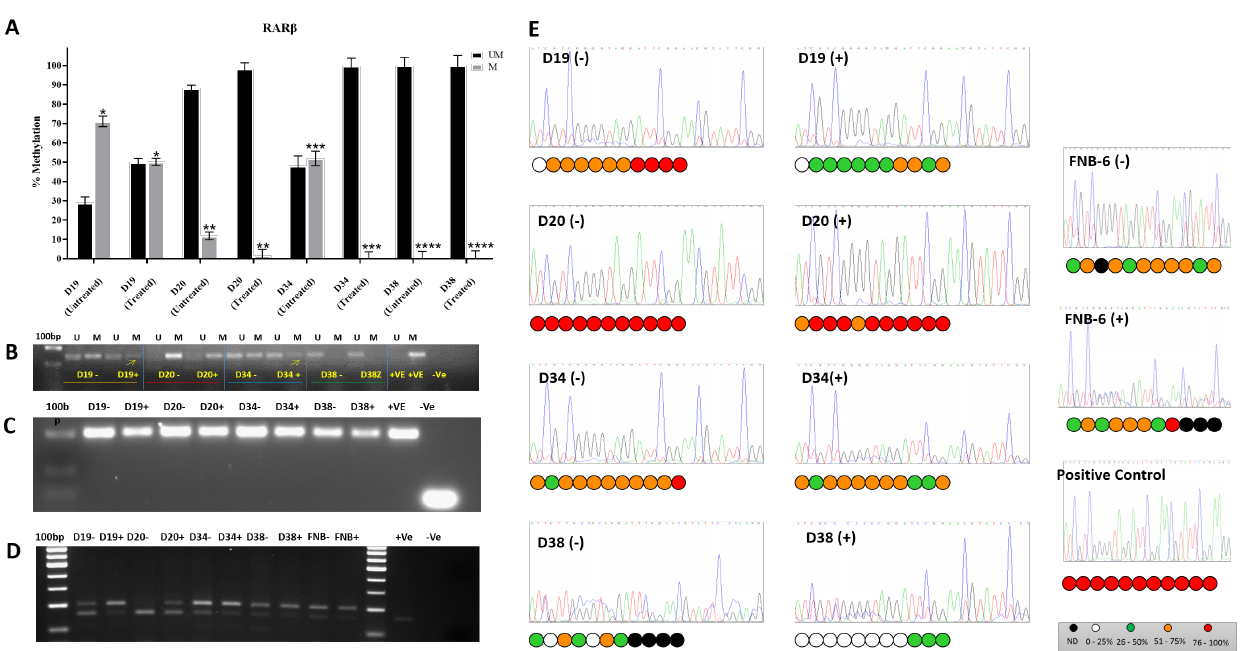
Figure 2. Promoter methylation analysis of the RAR β gene. ( A ) The proportion of RAR β -promoter methylation in D19, D20, D34, and D38 iPMOL cell lines, without (untreated) and treated with 5-AZA-CdR, as detected using the EpiTect Methyl II PCR Assay kit. The % of promoter methylation in D19, D20 and D34 reduced on treatment with 5-AZA-CdR (* p < 0.0001, ** p < 0.0017, *** p < 0.0001 **** p< 0.00005), whereas in D38, the promoter was completely unmethylated prior to treatment. ( B ) Using methylation-specific PCR on DNA from 5-AZA-CdR untreated and treated cells, the RAR β -promoter region (146 bp, consisting of 14 CG sites), was amplified using primers specific for methylation (M) and unmethylation (U), and the products run on a 3% agarose gel. In D19, D20, and D34 cell lines, there was decrease in the intensity of the methylated band’s intensity after treatment with 5-AZA-CdR. ( C ) Using bisulfite-specific primers in both treated (+) and untreated ( − ) cell lines, a 207 bp promoter region was amplified by PCR. Bands in the gel represent this product which was subsequently treated with TaiI restriction enzyme. ( D ) Treatment of the 207 bp product with TaiI restriction enzyme demonstrates differing sizes of methylated (larger fragment; upper band) and unmethylated (smaller fragment: lower band) fragments. The proportion of methylated and unmethylated fragments are altered in D19 and D34, and there is a reduction in the methylated fragment in D20. The unmethylated RAR β -promoter region in D38 remained unchanged before and after treatment. This pattern of alteration is in keeping with the EpiTect Methyl II PCR and Methylation-specific PCR data. ( E ) Sequencing of the bisulfite-treated DNA 207 bp product allowed calculation of the percentage of methylation at specific sites in the promoter (11 sites). The figure shows representative electropherograms of bisulfite sequencing reads from all iPMOL cells and FNB6TERT. From these, the percentage of CG methylation was calculated by comparing the peak height of cytosine with the sum of the heights of cytosine and thymine signals as represented. Abbreviation. UM = unmethylated fraction of DNA; M = methylated fraction of DNA; (+) treated; ( − )